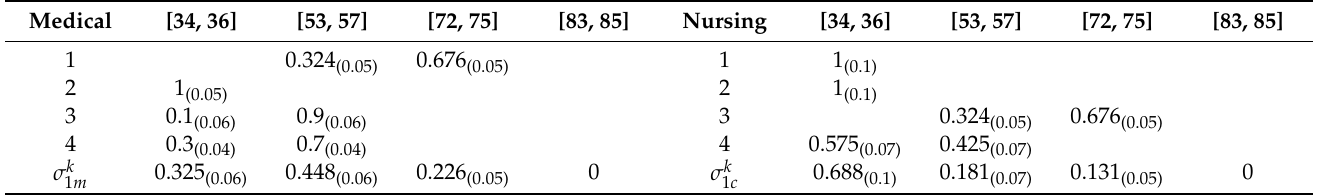
Table 3. Gray clustering